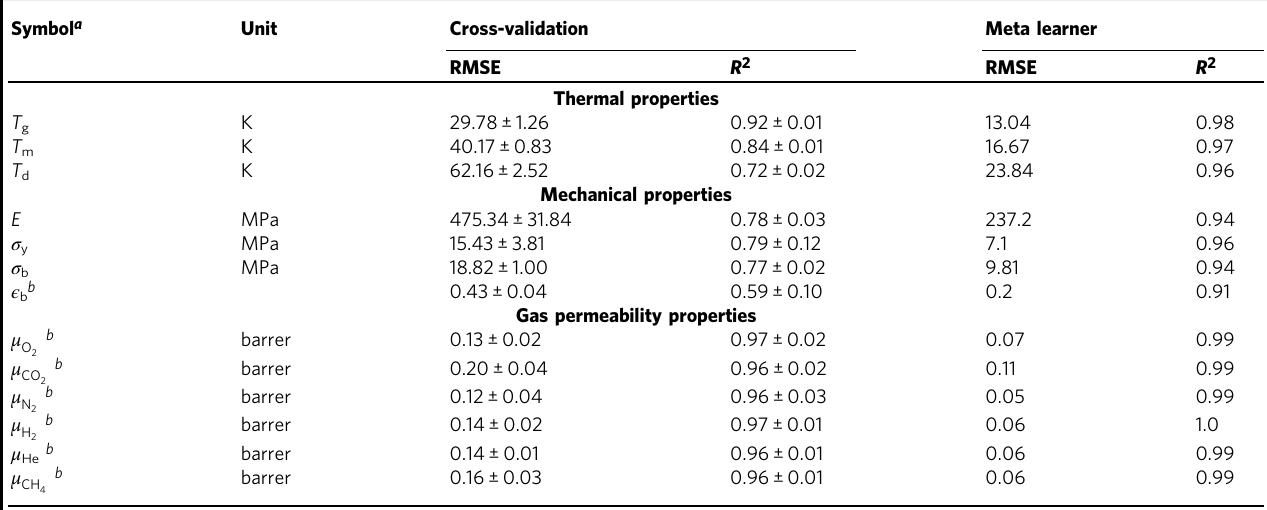
Table 2 The RMSEs and R 2 s averages of the fi ve cross-validation models and meta learner from predictions on the respective validation data sets. The cross-validation deviations show one standard deviation (1 σ ). Symbol